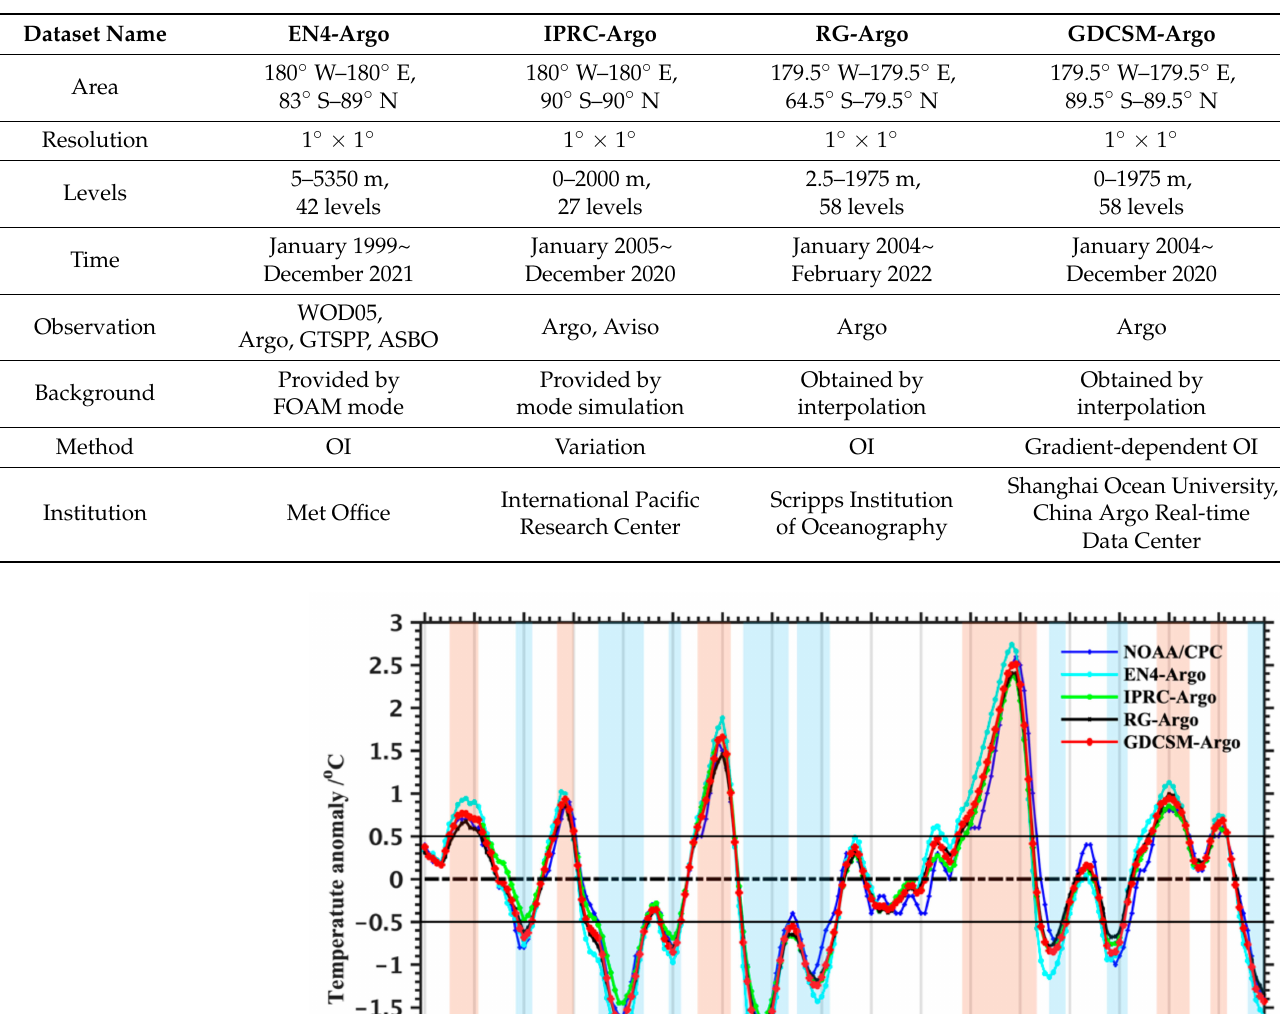
Table 2. Information on GDCSM-Argo and other gridded Argo datasets for comparison.